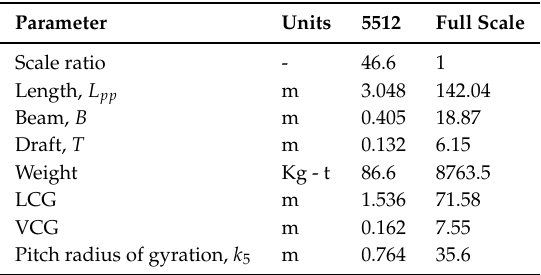
Table 1. DTMB 5512 hull and full scale characteristics.